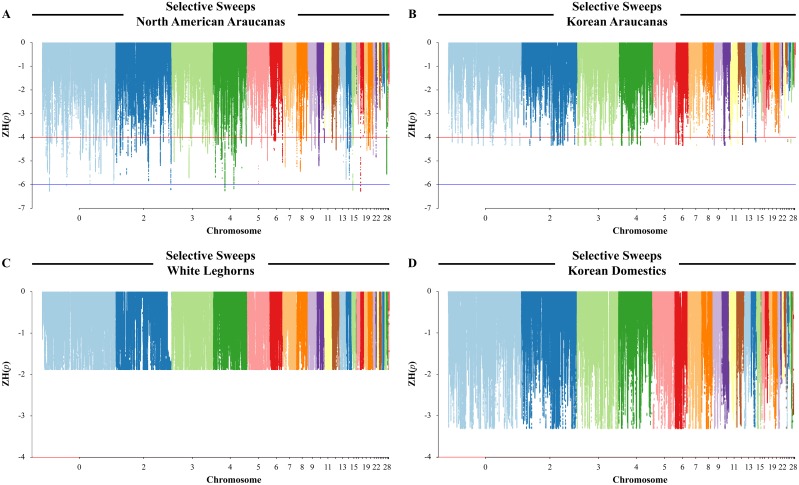
Selective sweeps.The negative tail of the ZHp distribution presented along chromosomes 1–28, 30, 32, 33, and LGE64. The Z and W chromosomes were not included because the sex of many birds in the study was not reported. Each dot represents a creeping window of up to 40 kb. The horizontal red line stands for the suggestive sweep significance level at ZHp = -4. The horizontal blue line stands for the strong sweep significance level at ZHp = -6. (A) Results from six North American Araucana, (B) results from three Korean Araucana, (C) results from three White Leghorns, and (D) results from three Korean Domestics.